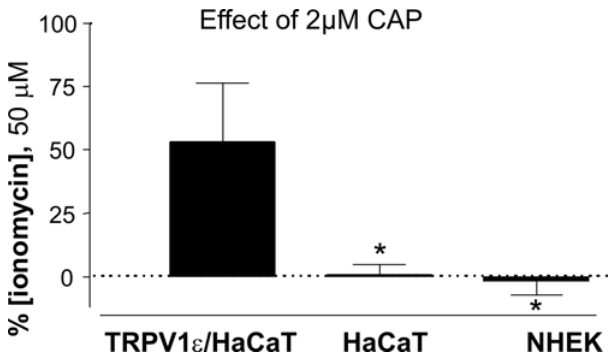
Figure 6. Fluorometric Ca 2 + imaging showed no capsaicin- induced Ca-signal in keratinocytes. Primary human keratinocytes and HaCaT cells were loaded with Fluo4-AM Ca 2 + -indicator then imaged in an appropriately equipped fluorescence microscope setup. The bars represent the increase in fluorescence upon capsaicin (2 m M) treatment as a % of the fluorescence increase after ionomycin treatment (50 m M). While TRPV1 transformed cells exposed to CAP showed readily detectable fluorescence changes, neither untransformed HaCaT cells, nor primary keratinocytes responded to this algesic vanilloid substance. Values are shown as means 6 SD for 6 measurement. The significance of differences compared with TRPV1 e /HaCaT was determined with the paired t-test, *P ,